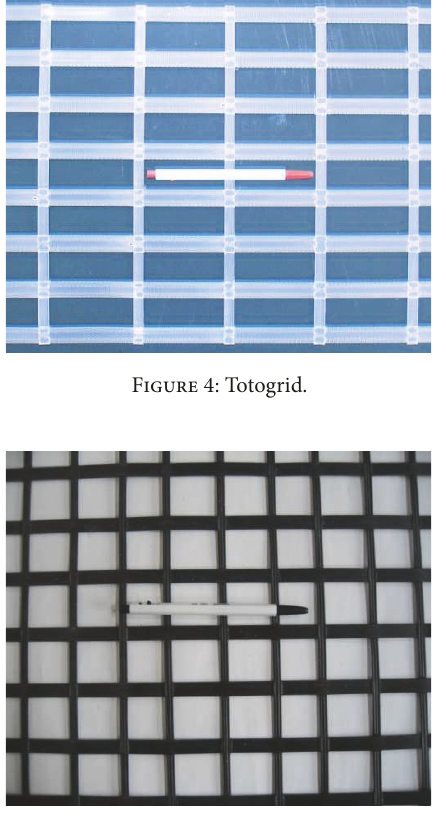
Figure 5: Fortrac geogrid.